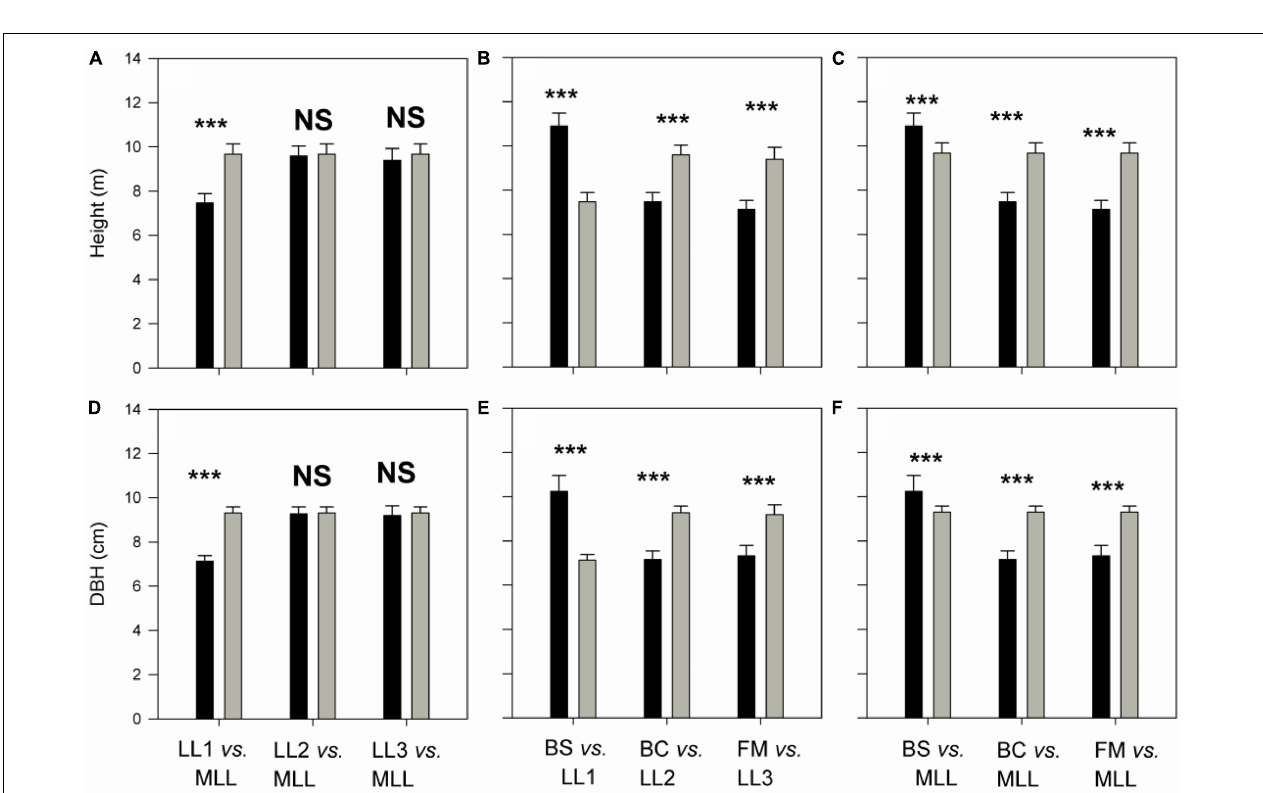
FIGURE 5 | Differences in average height and diameter at breast height (DBH) among monocultured L. leucocephala (MLL) , L. leucocephala that is mixed with selected native species ( B. spectabilis ) (LL1), L. leucocephala mixed with unselected native species ( B. ceiba and F. microcarpa ) (LL2 and LL3, respectively) and selected and unselected native species ( B. spectabilis, B. ceiba, and F. microcarpa ) on Baopoling hill after 3 years of planting. (A,D) Demonstrate the differences in average height and DBH between individuals of L. leucocephala in LL1 and MLL (LL1 vs. MLL), between LL2 and MLL (LL2 vs. MLL) and between LL3 and MLL (LL3 vs. MLL). (B,E) represent the differences in average height and DBH between L. leucocephala in LL1 and B. spectabilis (BS vs. LL1), between L. leucocephala in LL2 and B. ceiba (BC vs. LL2) and between L. leucocephala in LL3 and F. microcarpa (FM vs. LL3). (C,F) show the differences in average height and DBH between L. leucocephala in MLL and BS, between MLL and BC and between MLL and FM. Detail seedlings planting design are provided in Figure 4 . *** indicates P < 0.05 and NS (short for non-significant) indicates P > 0.05 based on Wilcoxon signed-rank test.